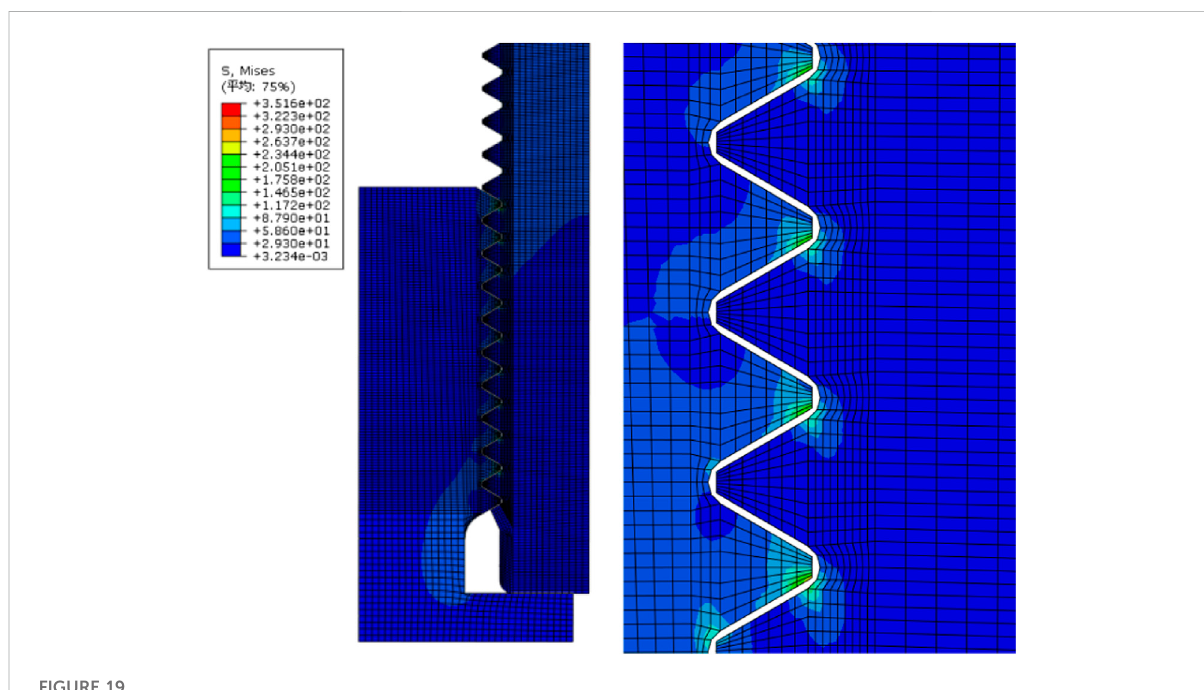
FIGURE 19 Circular stress cloud of the thread